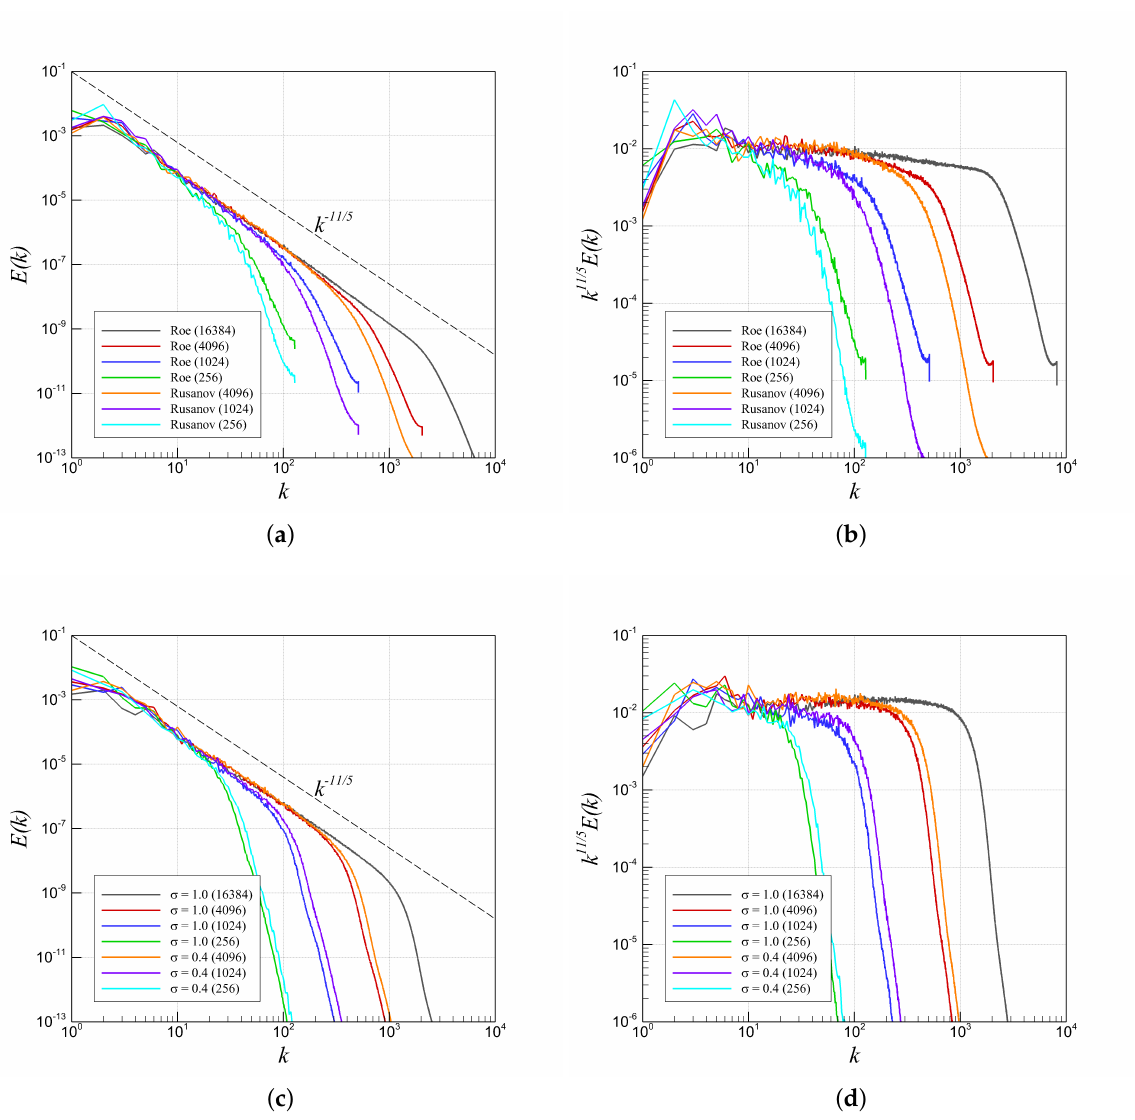
Figure 9. Comparison of ILES (ILES-Roe and ILES-Rusanov) models and CS+RF ( σ = 1.0 and σ = 0.4) models for the RTI problem with multi-mode perturbation showing the density-weighted kinetic energy spectra and compensated density-weighted kinetic energy spectra at different resolutions; ( a ) density-weighted spectra using ILES solvers; ( b ) compensated density-weighted spectra using ILES solvers; ( c ) density-weighted spectra using CS+RF solvers; ( d ) compensated density-weighted spectra using CS+RF